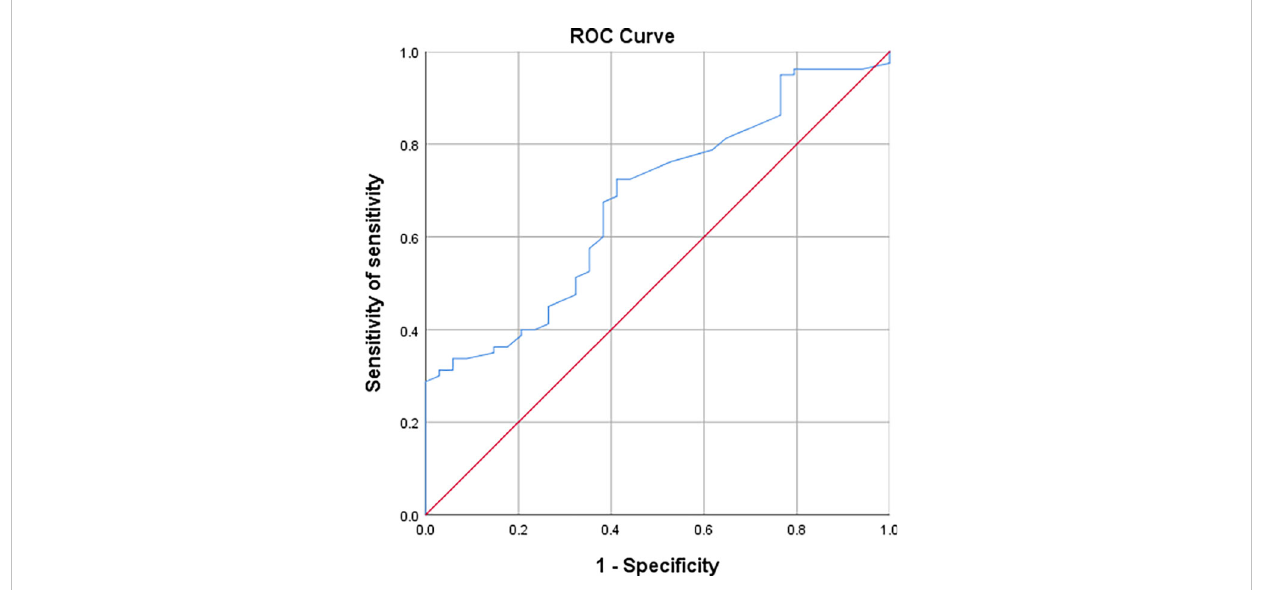
FIGURE 7 Working curves of subjects with nodal area indications differentiating AAH/AIS and